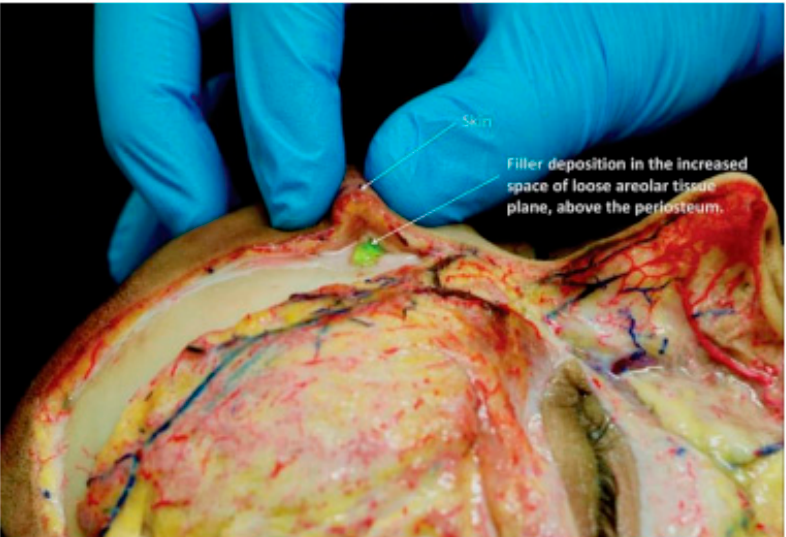
Figure 17. The forehead cadaver dissection and filler material’s position (green color) in the relatively avascular, loose areolar tissue layer [73].